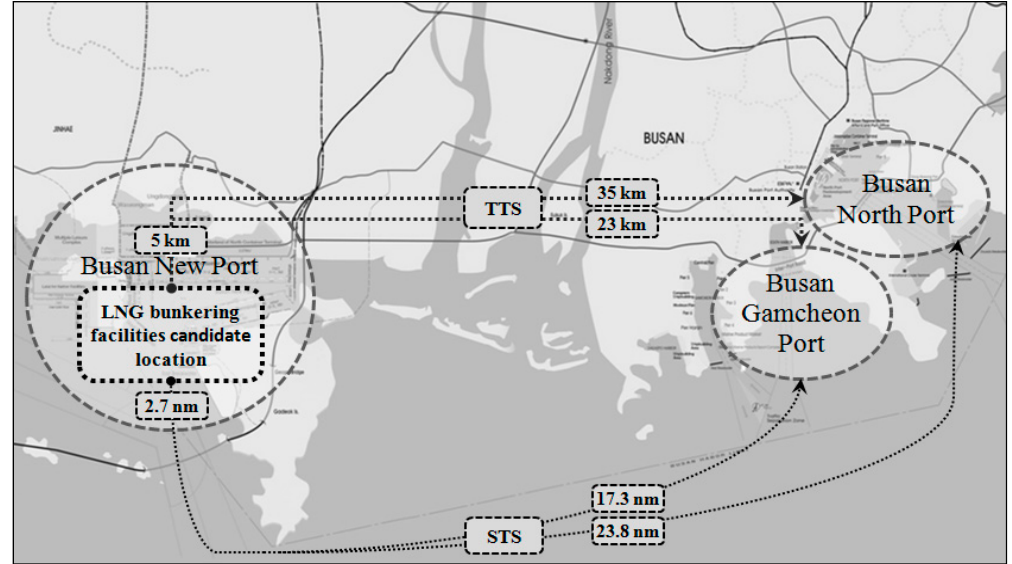
Figure 8. Reprinted the Map of Busan Port under Permission of Busan Port Authority (Modified from Ref. [28]).